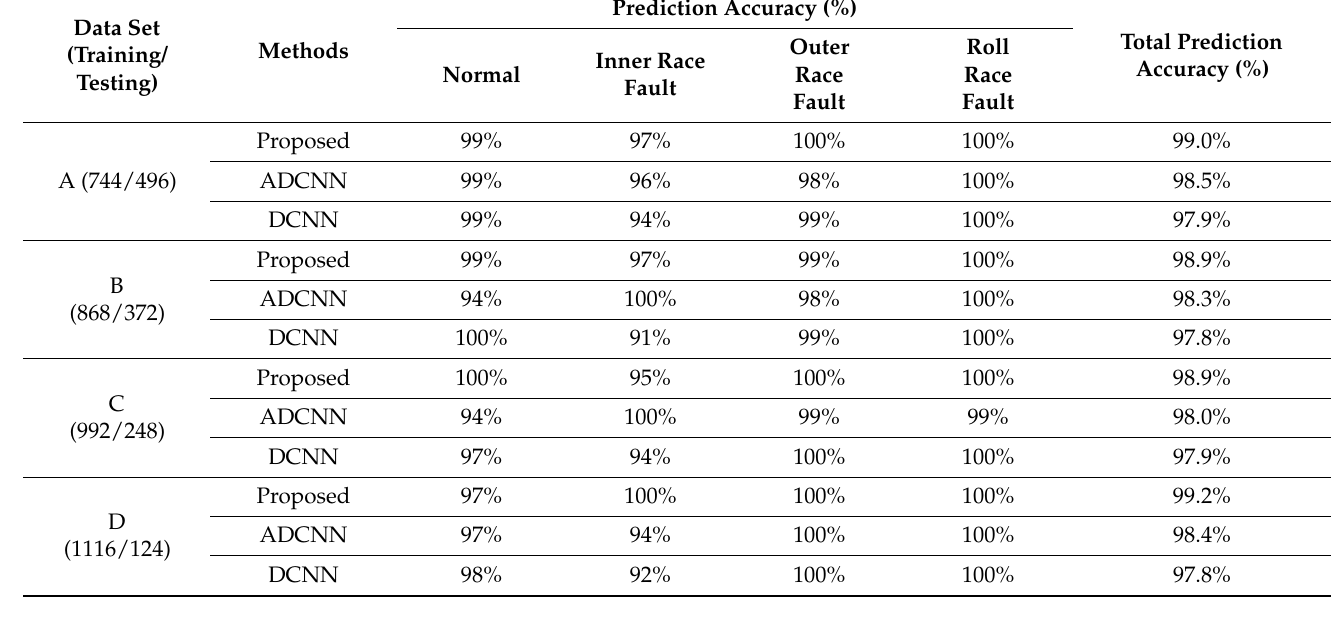
Table 4. Prediction precision for different methods.